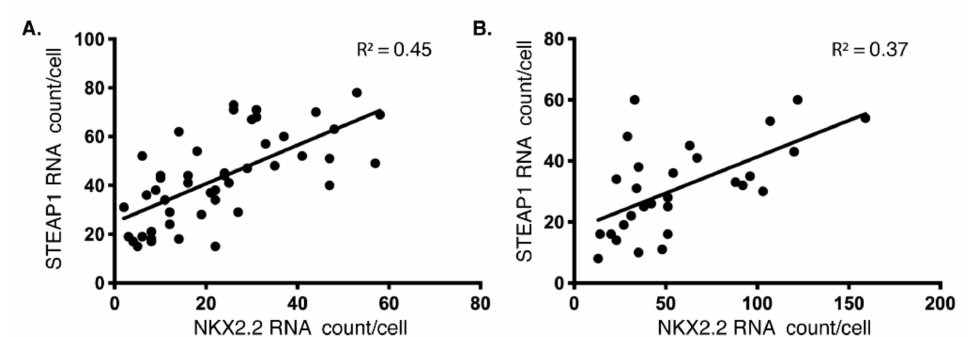
Figure 2. Positive correlation between NKX2.2 and STEAP1 levels: A dot plot with the number of NKX2.2 mRNAs on the X-axis and STEAP1 mRNAs on Y-axis obtained using smFISH in ( A ) type 1 fusion (A1795) and ( B ) type 2 fusion (HTB166) cell lines as described in Figure 1A. Each point on the plot represents a single cell. A linear trendline and R 2 value are shown on each plot to underscore the positive correlation between these two RNAs’ expressions at a single molecule level in individual